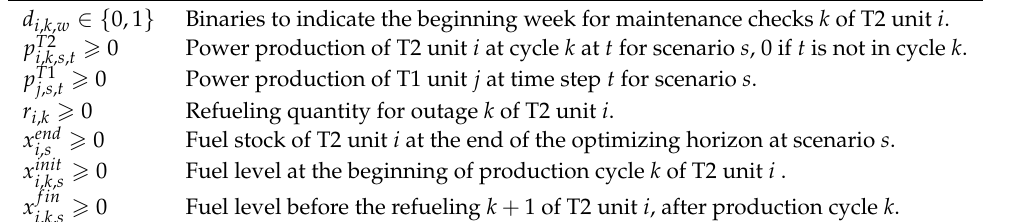
Table 4. Definition of the variables for the MILP formulation relaxing only constraints CT6 and